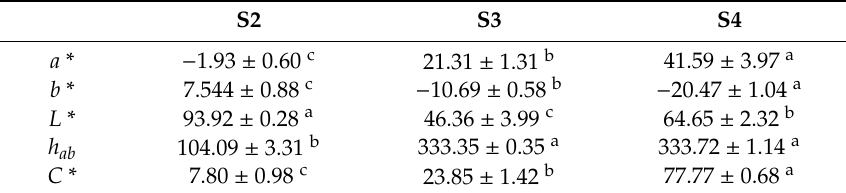
Table 2. Flower colour parameters in Pleroma raddianum petals. S2—white flowers (day 1), S3—pink (day 2), S4—purple (day